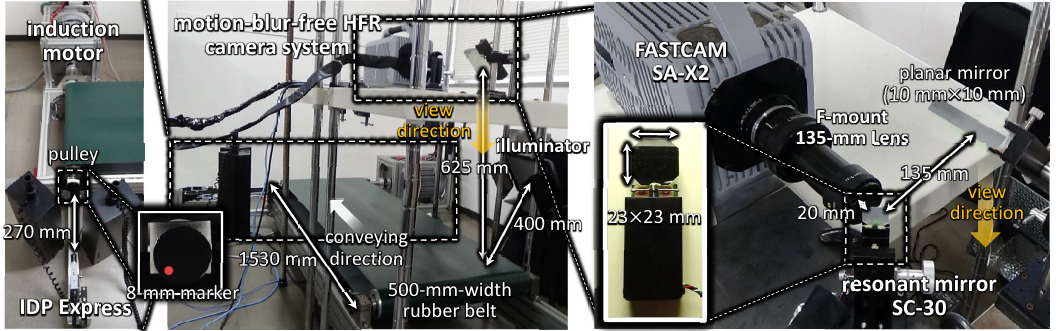
Figure 7. Overview of the test-bed system for motion-blur-free video